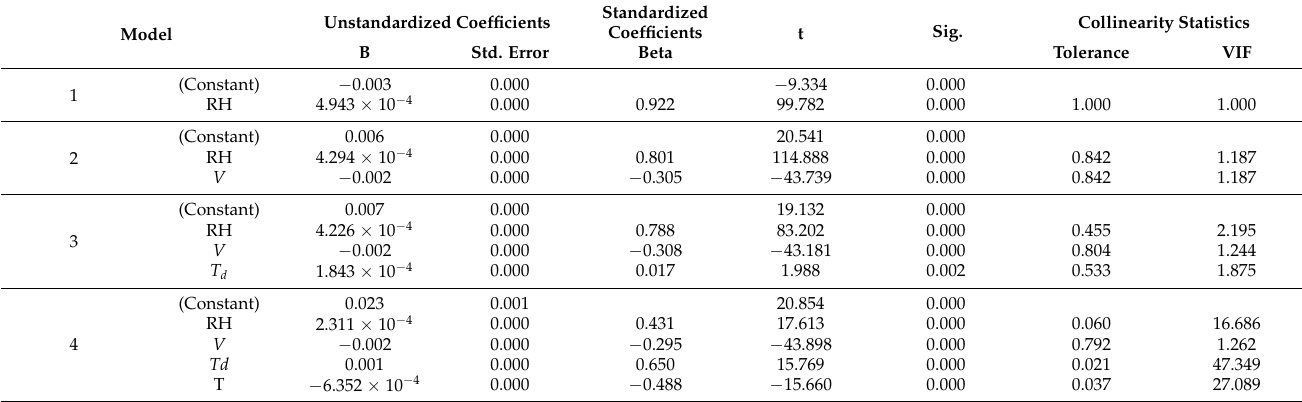
Table A2. Coefficients a